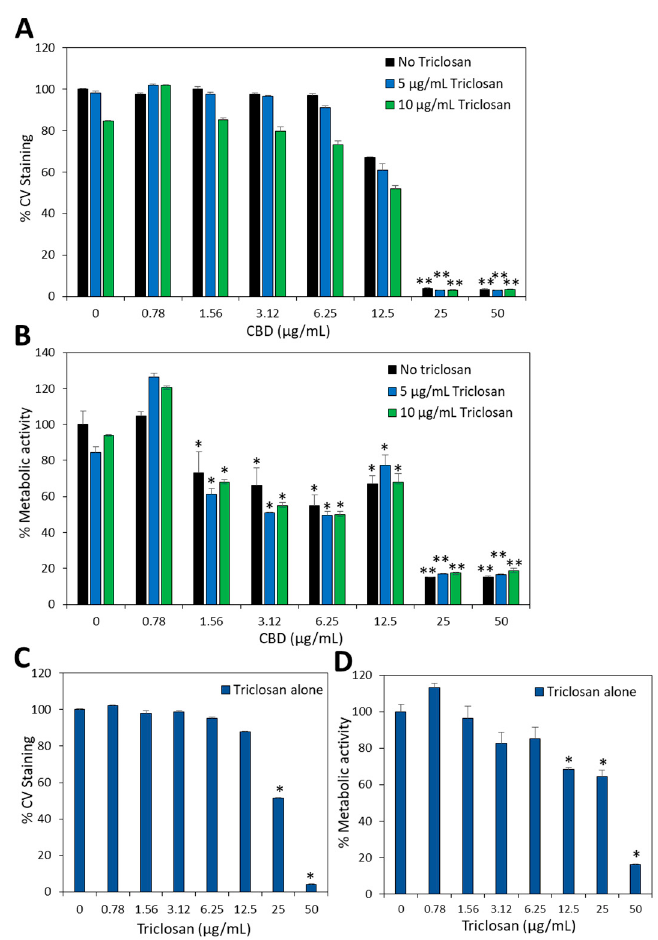
Figure 11. Biocompatibility assay on Vero epithelial cells. ( A , B ) Vero cell monolayer was incubated with various concentrations of CBD alone or in the presence of 5 or 10 µ g/mL Triclosan for 24 h and then either stained with CV for measuring the total cell mass ( A ) or exposed to MTT to measure the metabolic activity ( B ). ( C , D ) Vero cell monolayer was incubated in the absence or presence of increasing concentrations of triclosan for 24 h and then either stained with CV for measuring the total cell mass ( C ) or exposed to MTT to measure the metabolic activity ( D ). * p < 0.05 when compared to control cells. ** p < 0.01 when compared to control cells. N =